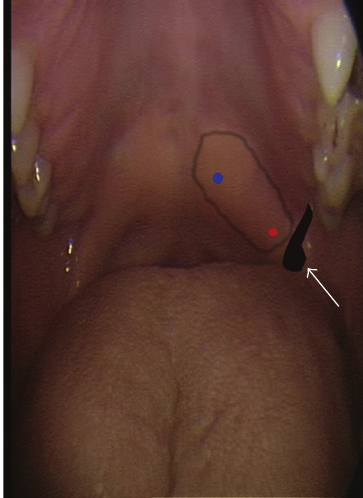
Figure 1: Injection site of botulinum toxin into insertion and aponeurosis of tensor veli palatini. Optimum relief of pulsatile tinnitus obtained with 7.5 units of botulinum toxin injected (red dot) just medial to pterygoid hamulus (white arrow) and 3 units of botulinum toxin injected just lateral to musculus uvulae (blue